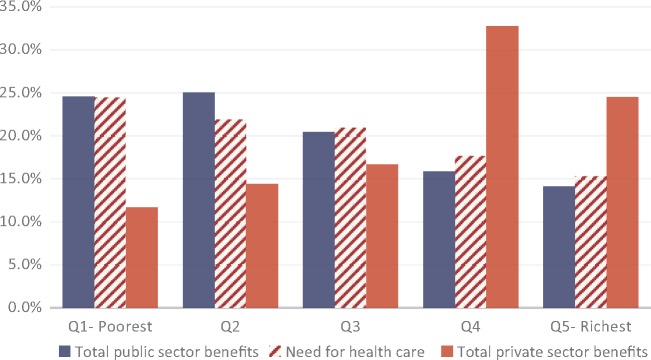
Distribution of benefits and need for healthcare.